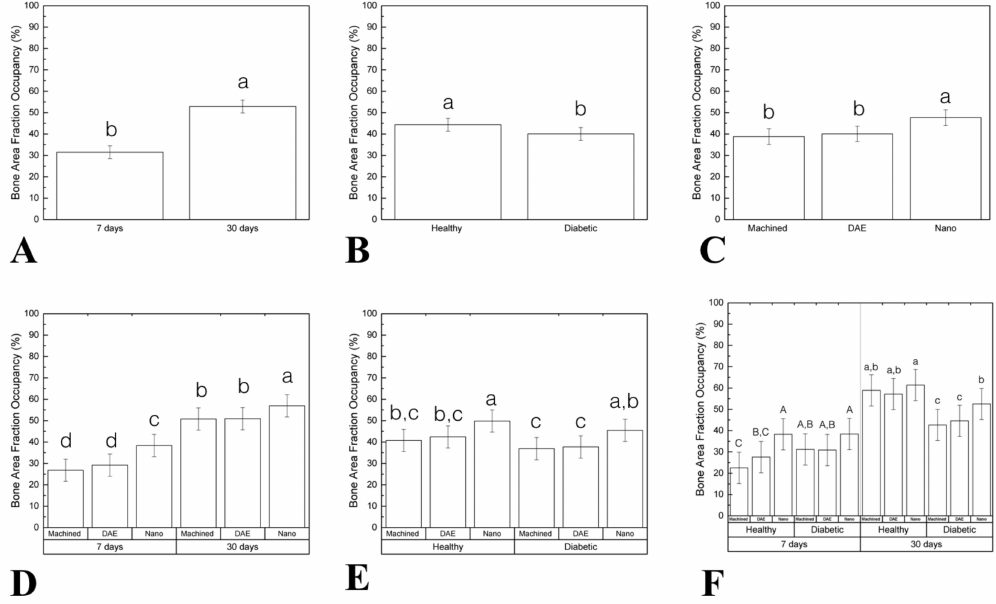
Figure 5. ( A – F ) Graphs representing the percentage of bone area fraction occupancy (%BAFO) di ff erently arranged as a function of study factors (mean and 95% CI). Significant di ff erence was seen between 7 and 30 days in vivo ( A ). Statistically significant di ff erence was found when comparing the healthy and diabetic group (data as function of systemic condition) ( B ). When implant surface was considered, the NANO group exhibited higher %BAFO relative to machined and DAE groups (data as a function of implant surface) ( C ). Data evaluation as a function of time and implant surface highlighted the superiority of NANO group at 30 days compared to others ( D ). No statistically significant di ff erences were found when %BAFO was evaluated as a function of systemic condition and surface ( E ). Evaluating all factors (time, systemic condition, and surface treatment) the results revealed that NANO surface presented the best results at 7 days (healthy group) ( F ). Identical letters indicate no significant di ff erence among